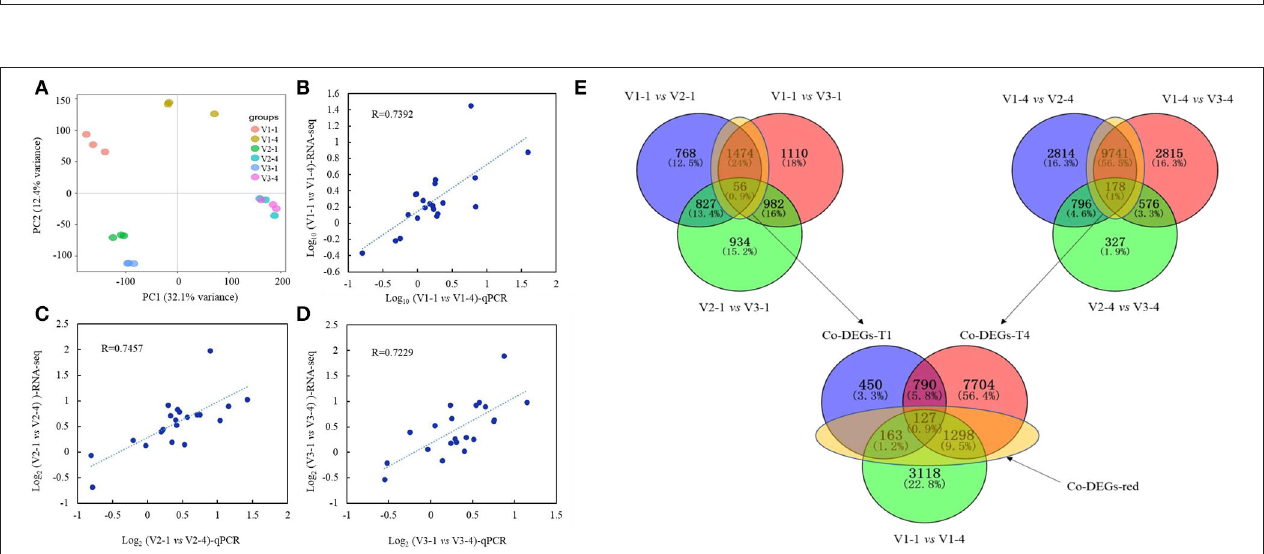
FIGURE 3 | Heatmaps of the accumulation level of differentially accumulated metabolites after normalization and KEGG analysis of Co-DAMs-red. Heatmaps were drawn after normalization, that is take the sum of each metabolite accumulation value in all 6 samples as 1, and calculate the ratio in the sum. (A,C) were at positive mode; (B,D) were at negative mode.